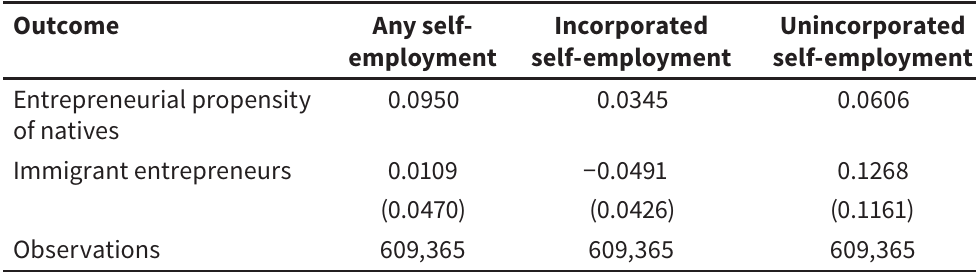
Impact of immigrant entrepreneurs on entrepreneurial propensities of natives: TSLS